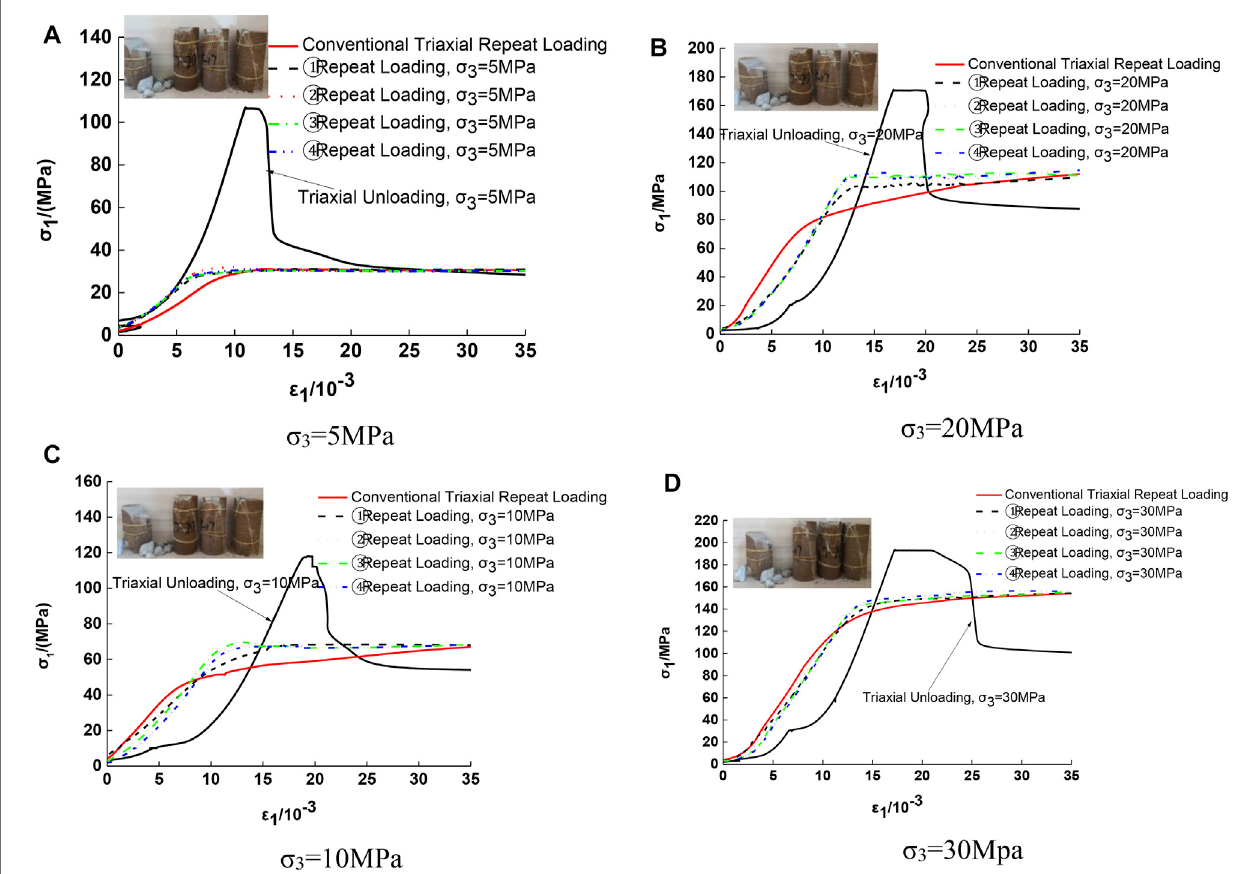
FIGURE 3 | Stress-strain curves of triaxial unloading test and single specimen repetitive compression test under different con fi ning pressures. (A) σ 3 =5MPa. (B) σ σ σ 3 =10MPa. (C) 3 =20MPa. (D) 3